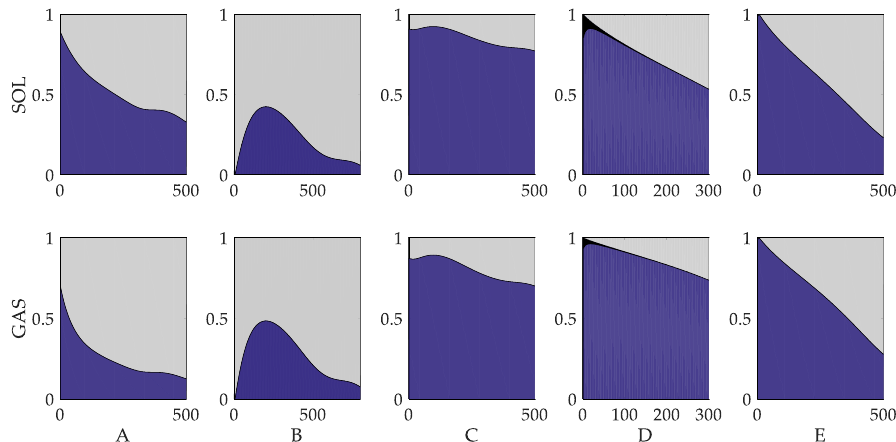
Figure 14. Ratio of d a part contribution to p a part contribution. Column (a) to (e) represents the results of subject A to E, respectively. The blue area the contribution of the d a part. The gray area represents the contribution of the p a part. Each column represents one subject. The x-axis is the time.